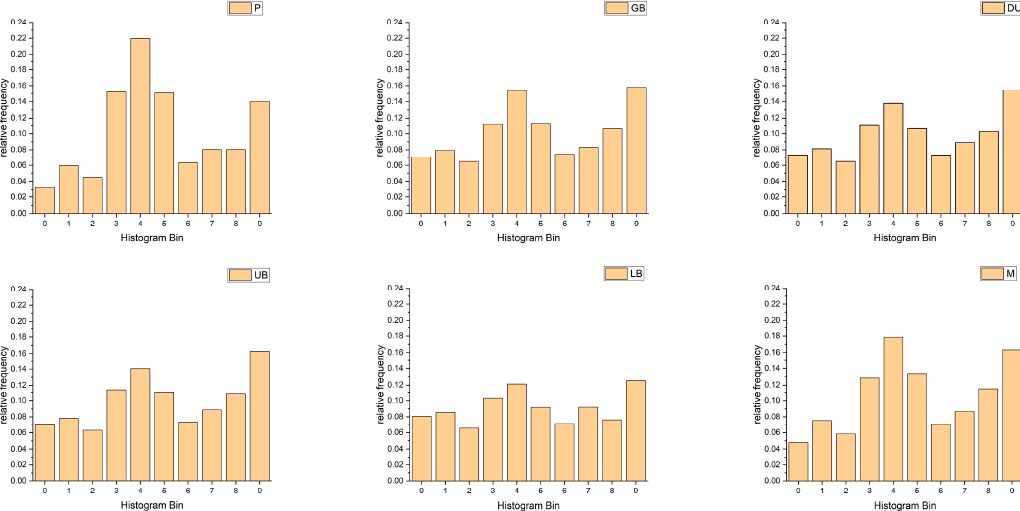
Figure 10. Averaged histograms of LBP with R = 1 and N = 8 of all images for all six microstructure classes. Averaging performed by calculating the mean value of the separate bins for every analyzed image.